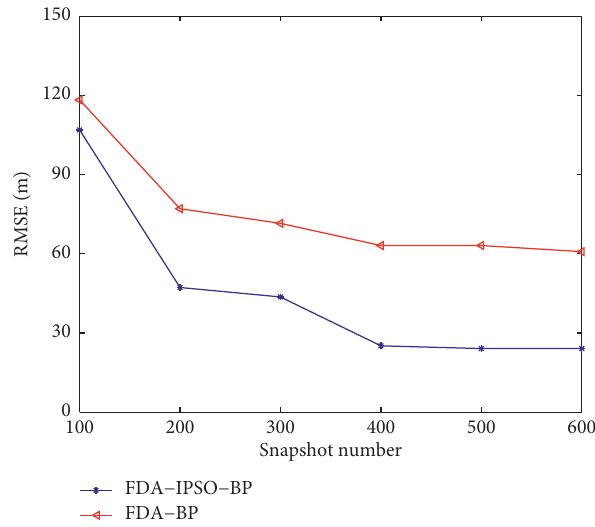
Figure 8: RMSE of range estimation versus snapshot.